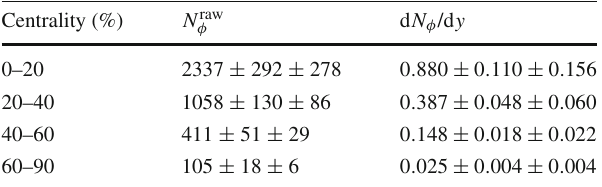
Table 2 N raw φ and d N φ /d y in different centrality bins for 2 < p T <